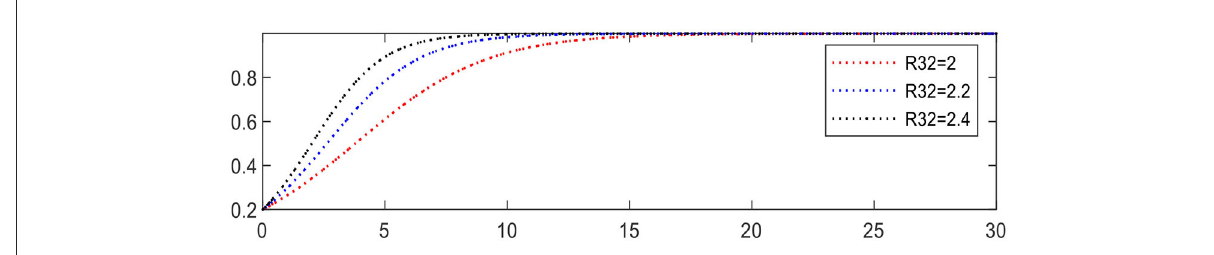
FIGURE14 Evolution of intelligent medical device providers (different R 32 ).